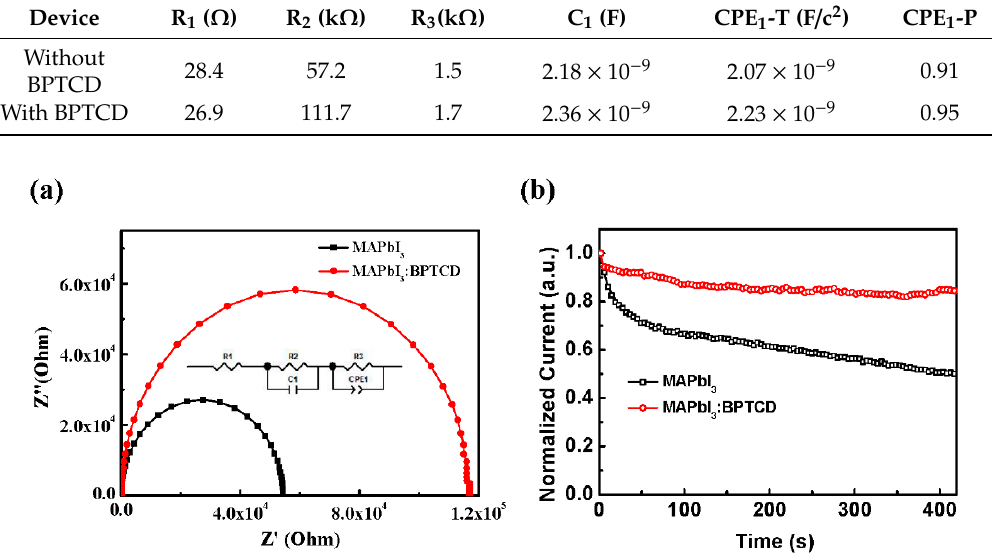
Figure 5. ( a ) Impedance spectra of PePDs, inset shows the corresponding equivalent circuit; ( b ) Long-term I ph measurement of PePDs with and without BPTCD (under 100 mW/m 2 white light).